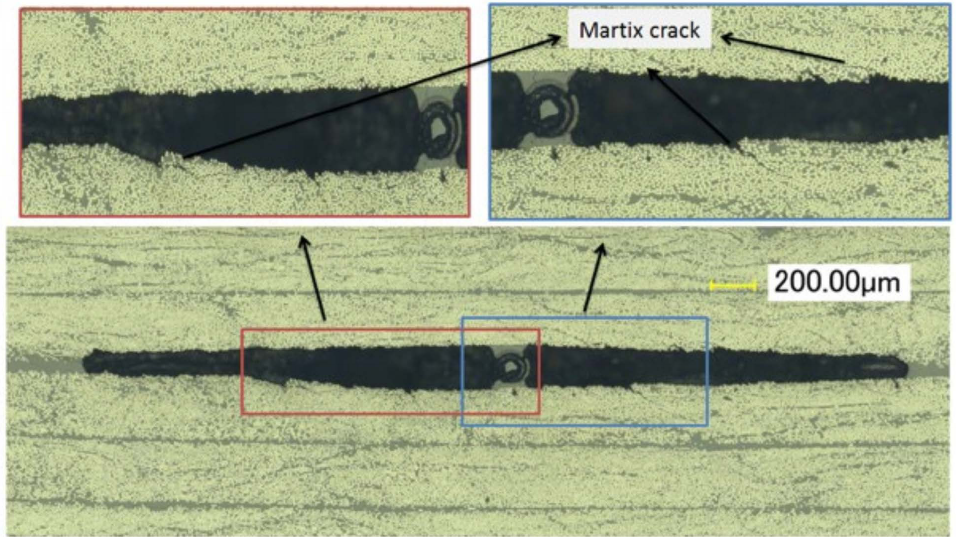
Figure 25. Numerical microscopy analysis for damage in postmortem cross-section—angle-ply specimen with